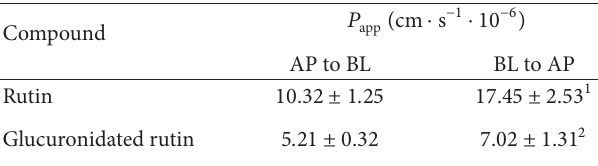
Table 1: Permeability ( 𝑃